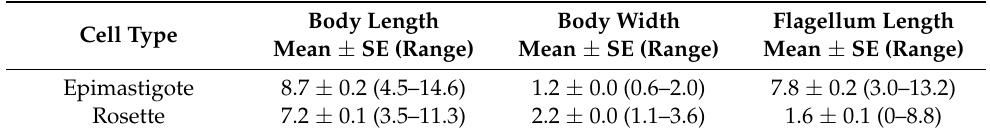
Table 1. Morphometry of trypanosomes in mosquito gut. Values in micrometers. SE, standard error. At least 30 cells were measured for each strain/host combination.